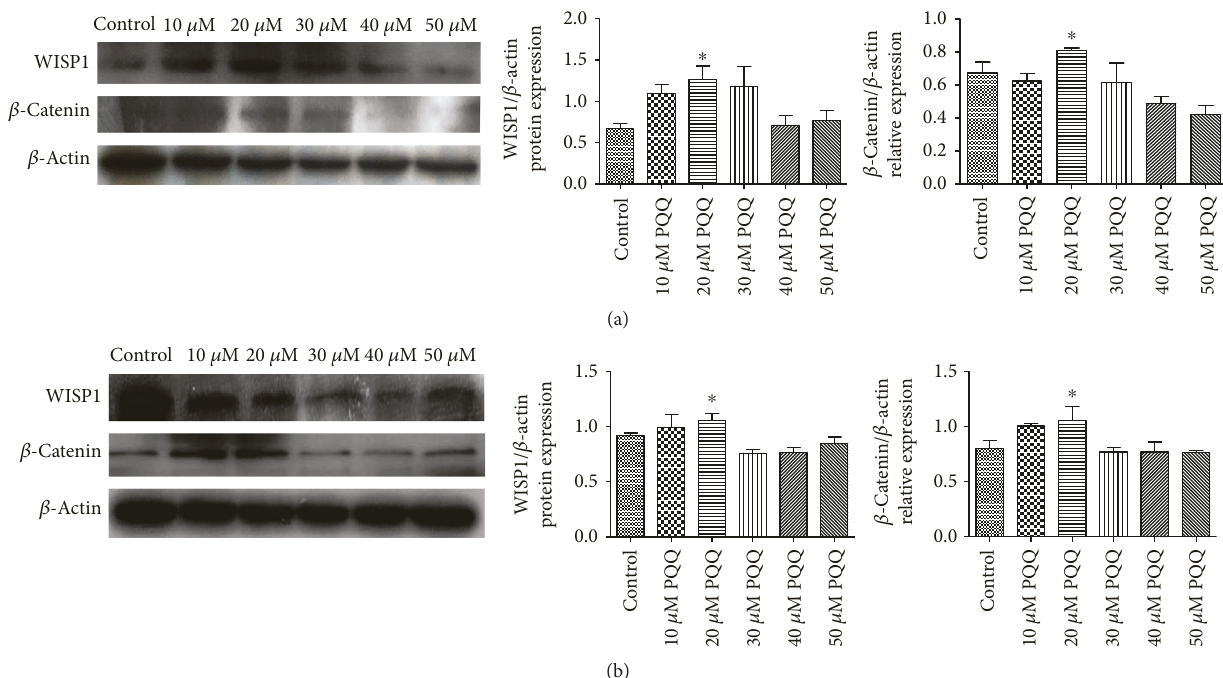
Figure 13: WISP1 and β -catenin protein expressions in PC12 cells and SHSY5Y cells with the treatment of di ff erent concentrations of PQQ. (a) Control: PC12 cells without PQQ; 10, 20, 30, 40, and 50 μ M: di ff erent concentrations of PQQ for 24 h; (b) control: SHSY5Y cells without PQQ ( ∗ P < 0 05 ).